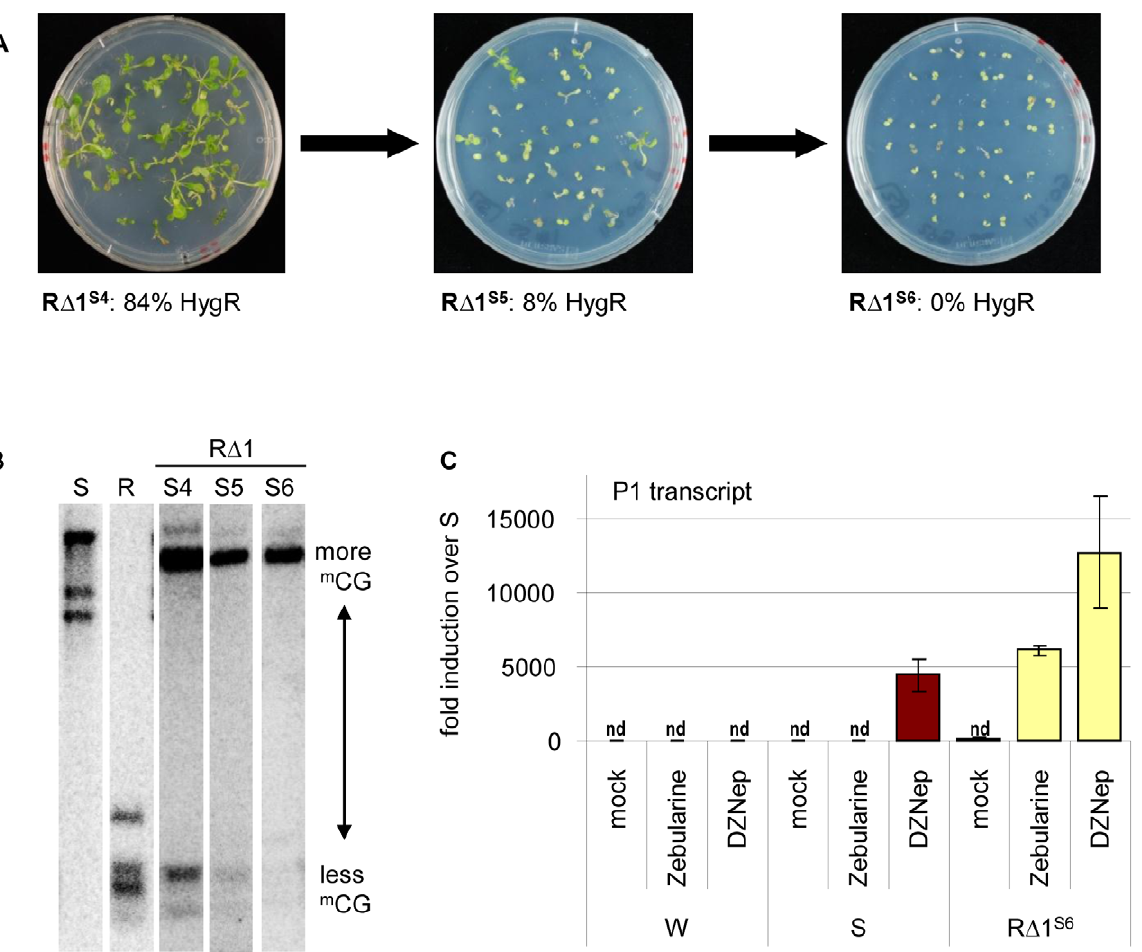
Figure 5. Different stability of reactivation after sequence rearrangement. (A) Hygromycin resistance in later generations of mutant R D 1. (B) Progressive methylation in later generations of mutant R D 1. Analysis as in Figure 4. (C) Effect of drug treatment (mock, 40 m M zebularine or 2 m M DZNep) on P1 transcript levels determined by qRT-PCR. Normalization to S; nd: not detectable, reference gene EIF4a (At3g13920); error bars represent standard deviation of triplicate measurements; wild type (W), line S (S) and cis -mutant R D 1 in generation